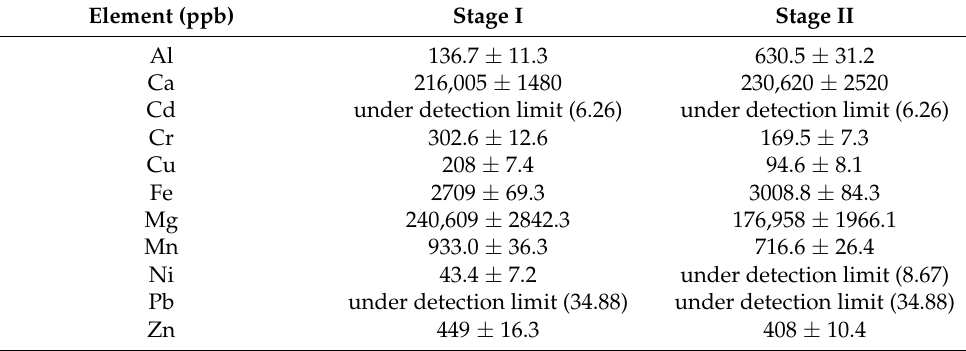
Table 2. Metal content in the tested landfill